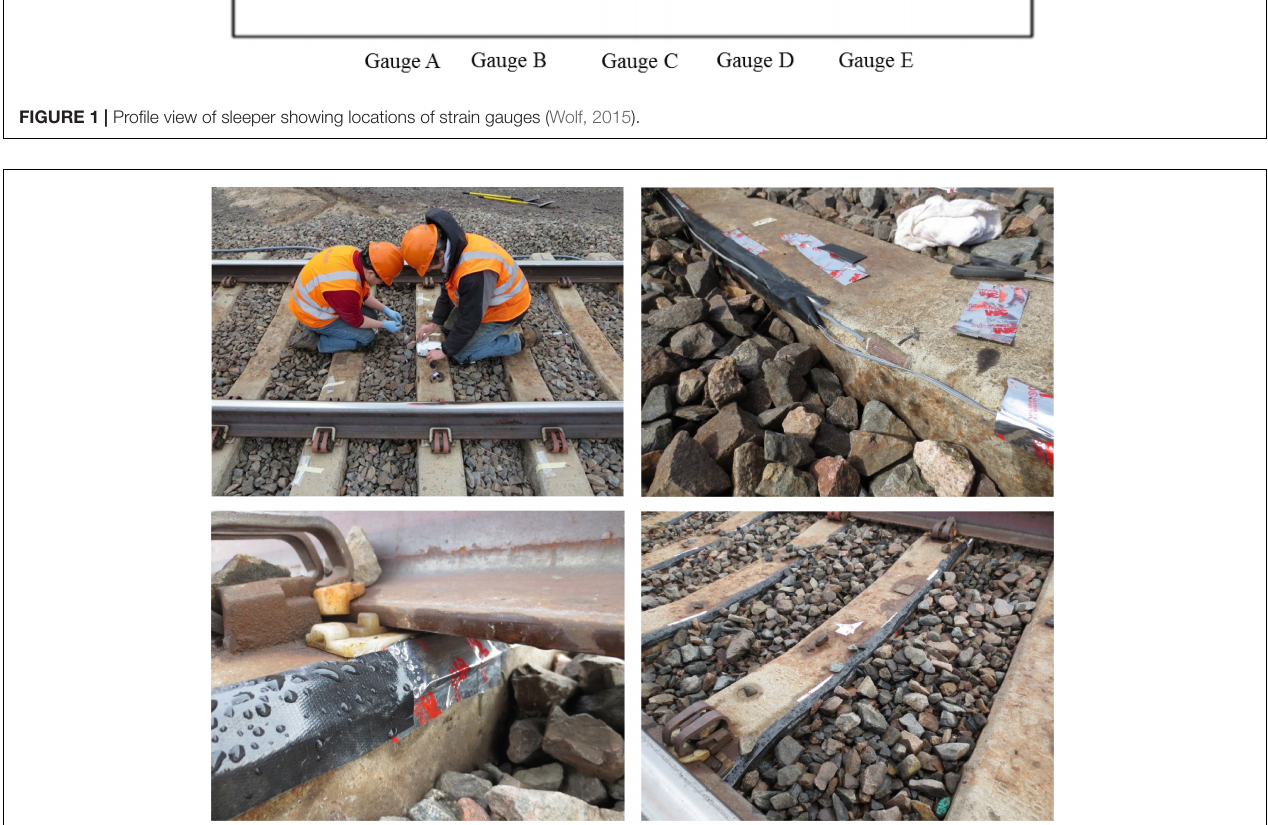
FIGURE 2 | Images of sleepers instrumented with concrete surface strain gauges at a HAL freight railroad field experimentation